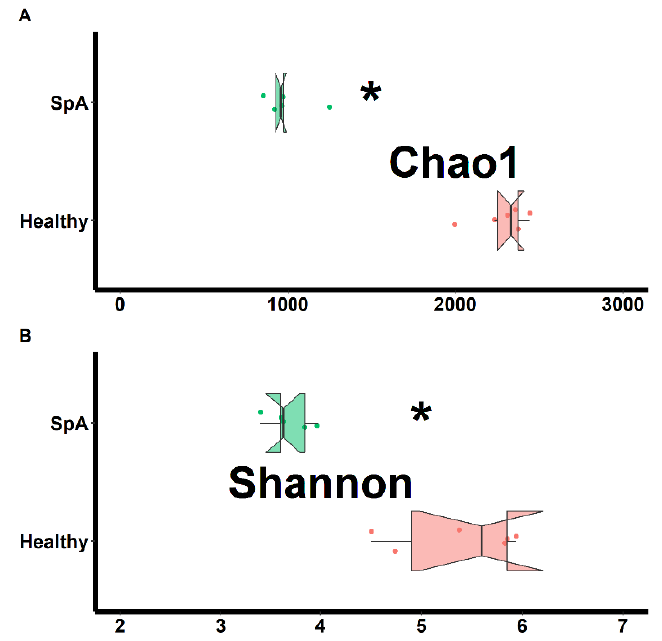
Figure 1. Assessment of richness (chao1; A ) and evenness (Shannon; B ) obtained from the sub-gingival sulcus of patients with Spondyloarthritis (SpA) and healthy controls. * indicates statistically significant at p < 0.01.